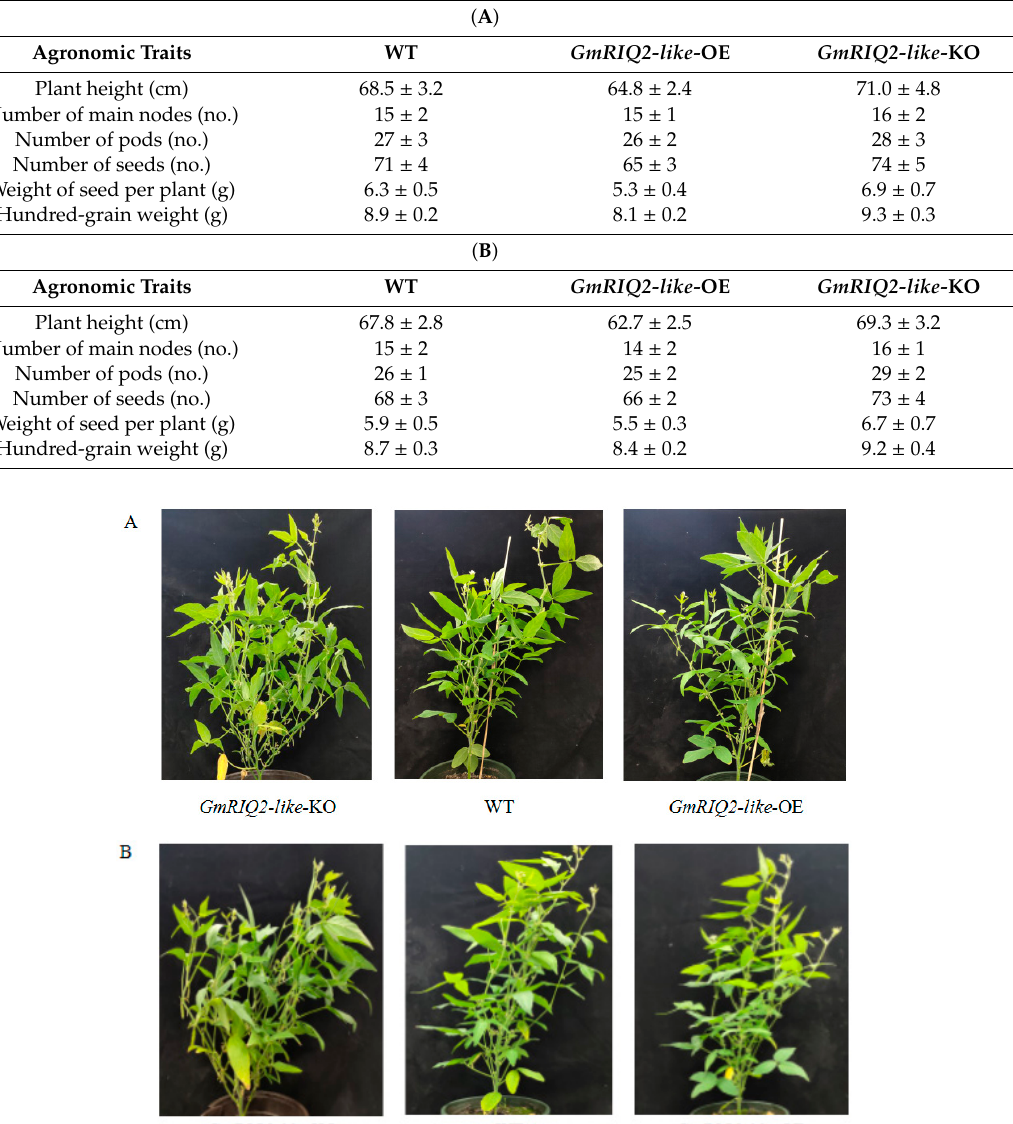
Table 4. ( A ) Agronomic traits of the wild-type (WT) and T 2 generation of GmRIQ2-like- OE and -KO transgenic seedlings. ( B ) Agronomic traits of the WT and T 3 generation of GmRIQ2-like- OE and -KO transgenic seedlings.